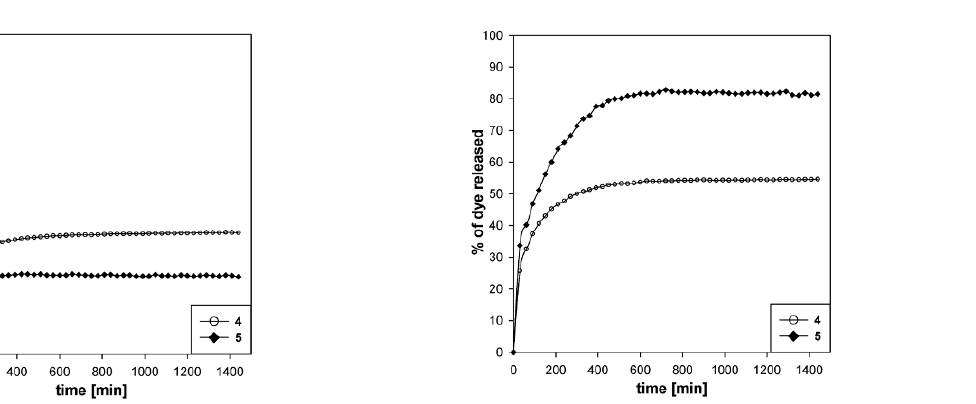
Figure 7. Release of 1 from modified MCM-41 silica at pH= 4.5.